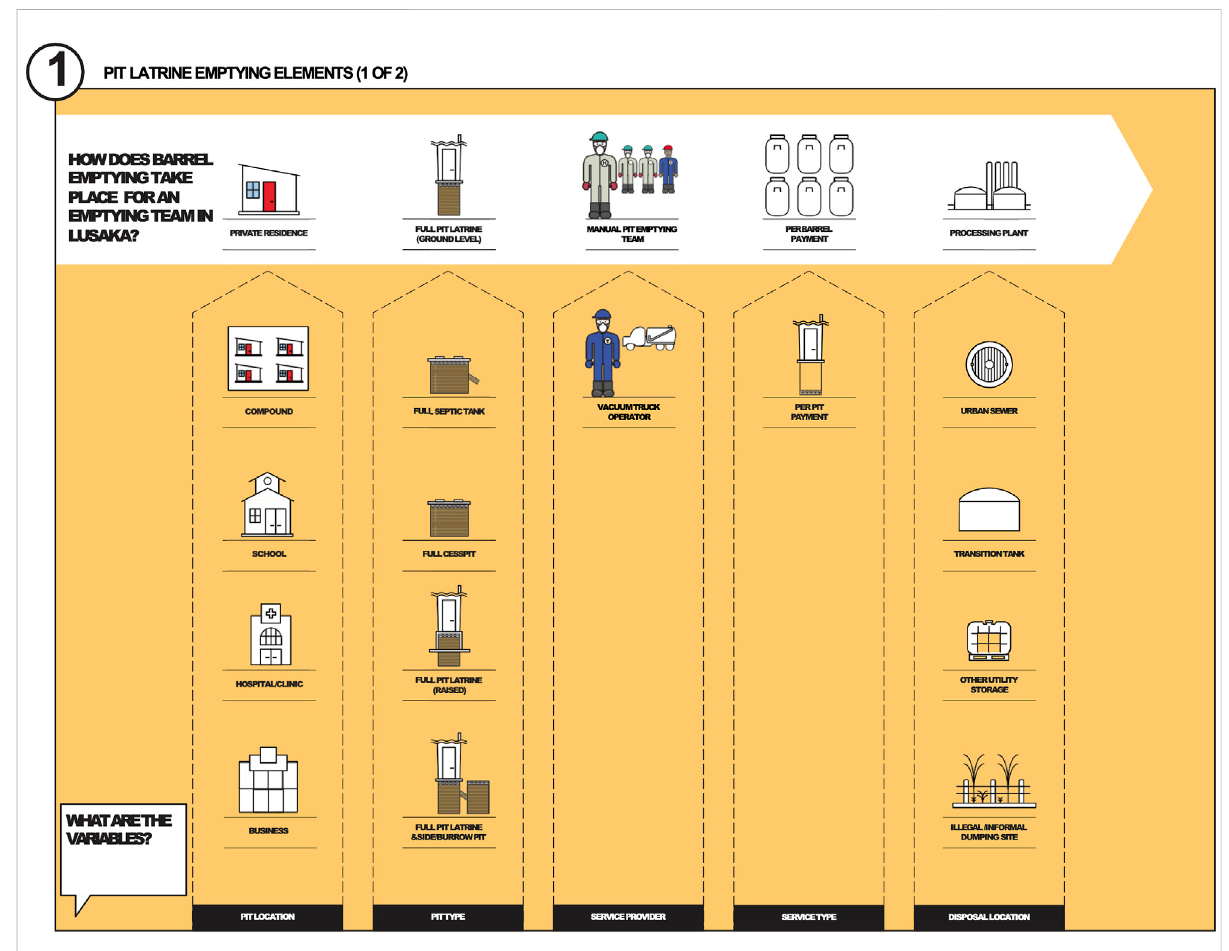
FIGURE 1 Excerpt of pit latrine emptying elements in manual pit latrine emptying. See Supplementary Material for the complete